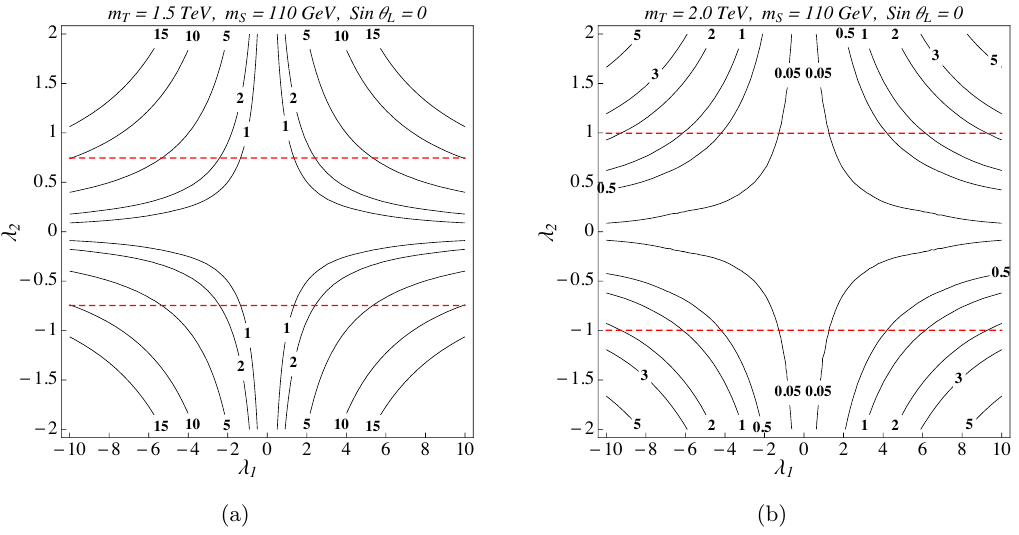
Figure 21 . Contours of constant signi(cid:12)cance, eq. (6.34), for two benchmark T mass scales (a) m T = 1 : 5 TeV and (b) m T = 2 : 0 TeV assuming a luminosity of 3 ab (cid:0) 1 . We set other parameters to m S = 110 GeV and sin (cid:18) L = 0. The dashed red lines illustrate the bounds coming from the diphoton resonance searches as presented in (cid:12)gure